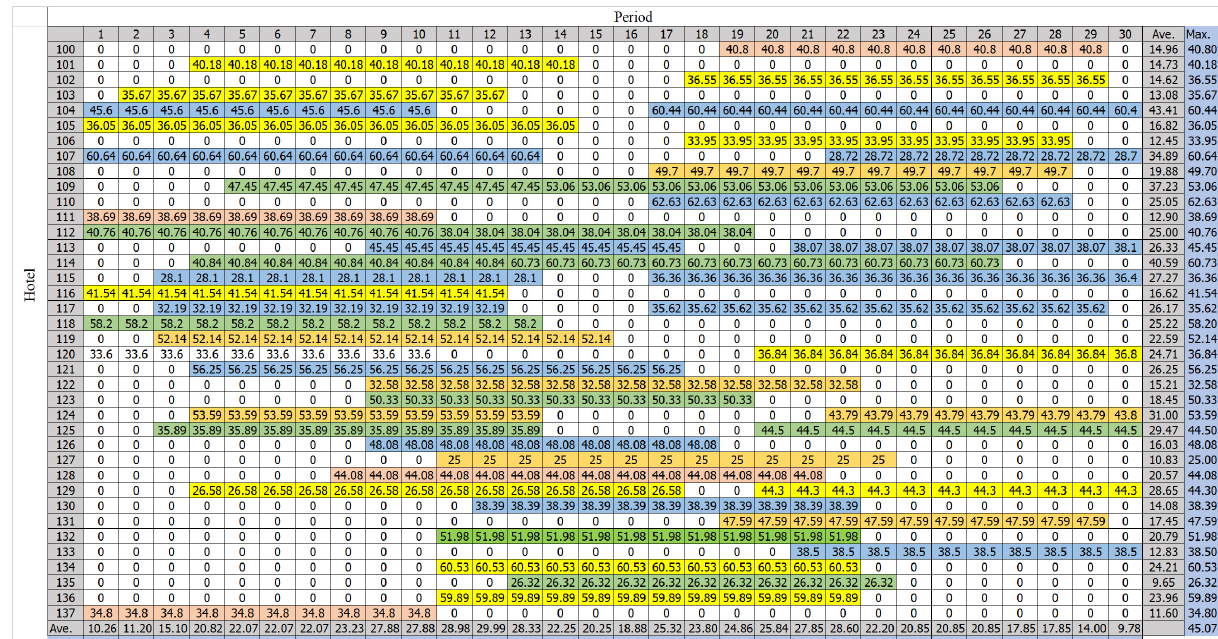
Figure 7. Gantt chart of the hotels and their utilization.